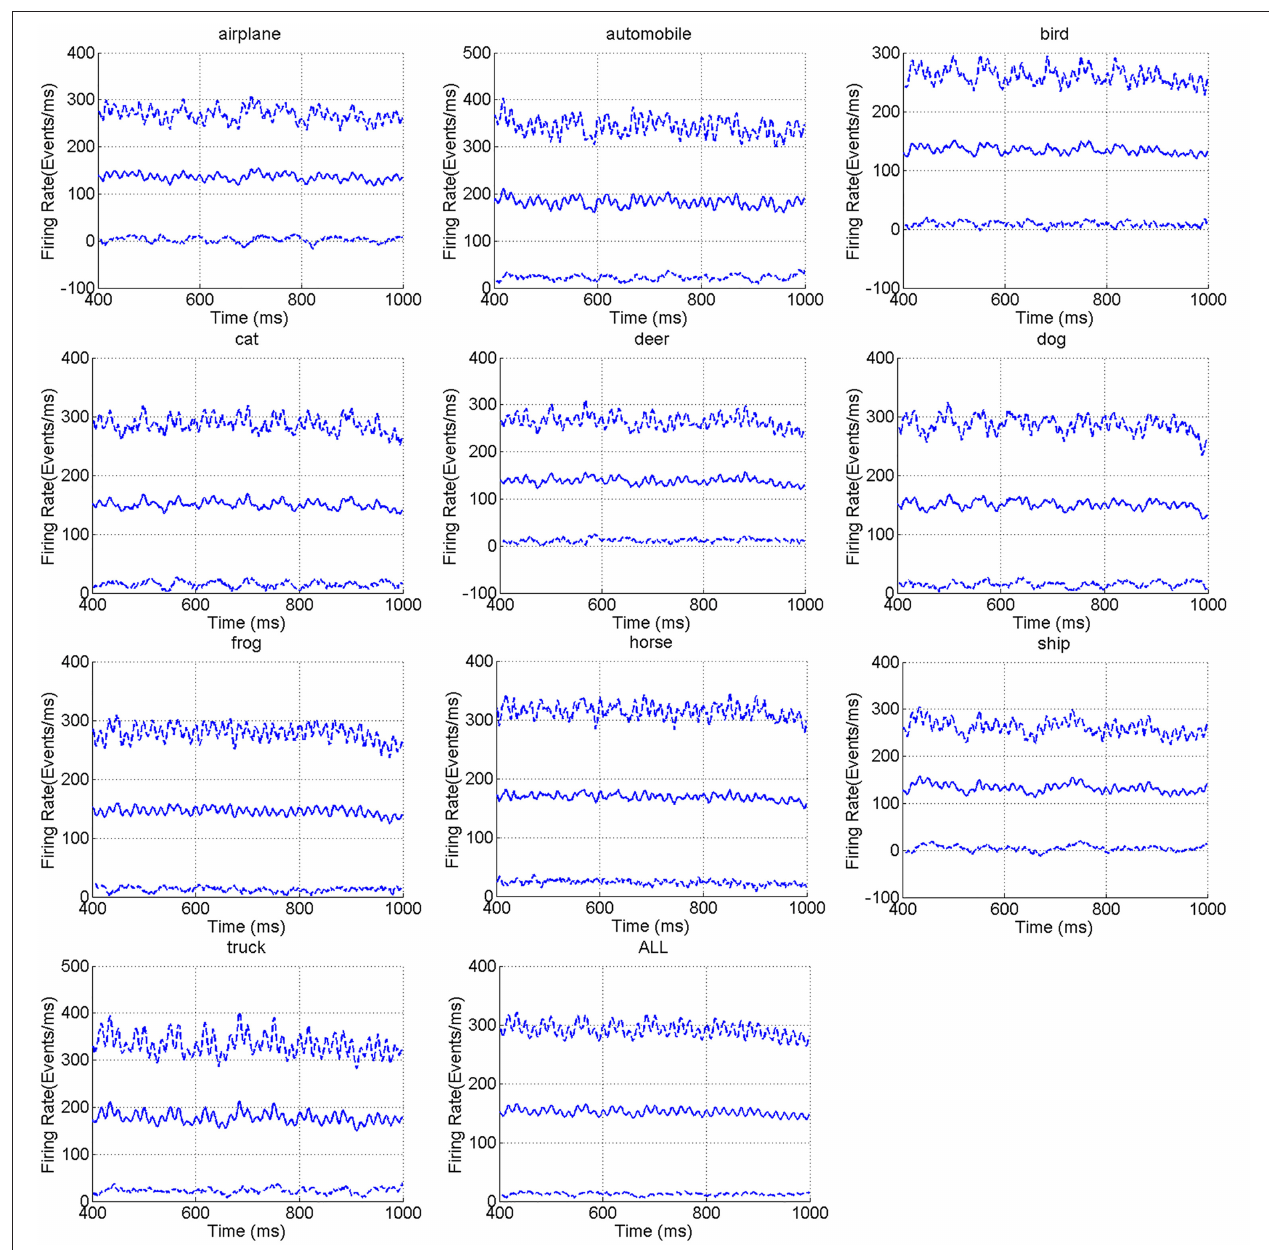
FIGURE 5 | The mean firing rate (solid line) and mean ± standard deviation firing rate (dotted line) for the CIFAR10-DVS